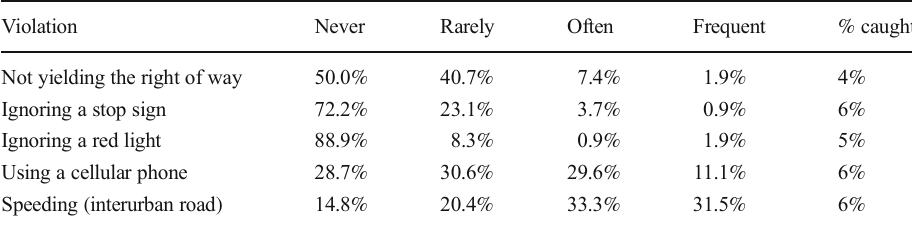
Table 2 Self-reported history of traffic violations over the